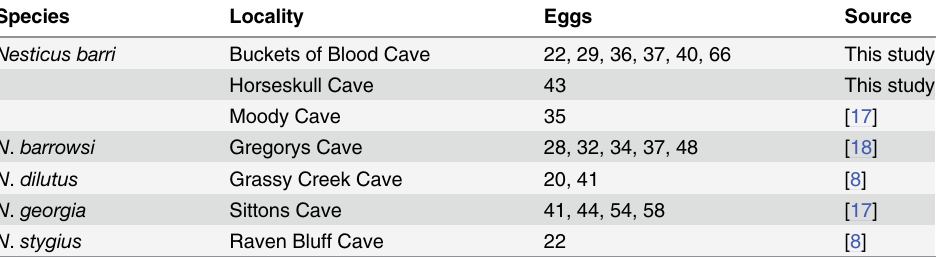
Table 2. Number of eggs per egg sac for troglobiotic Nesticus from the southern